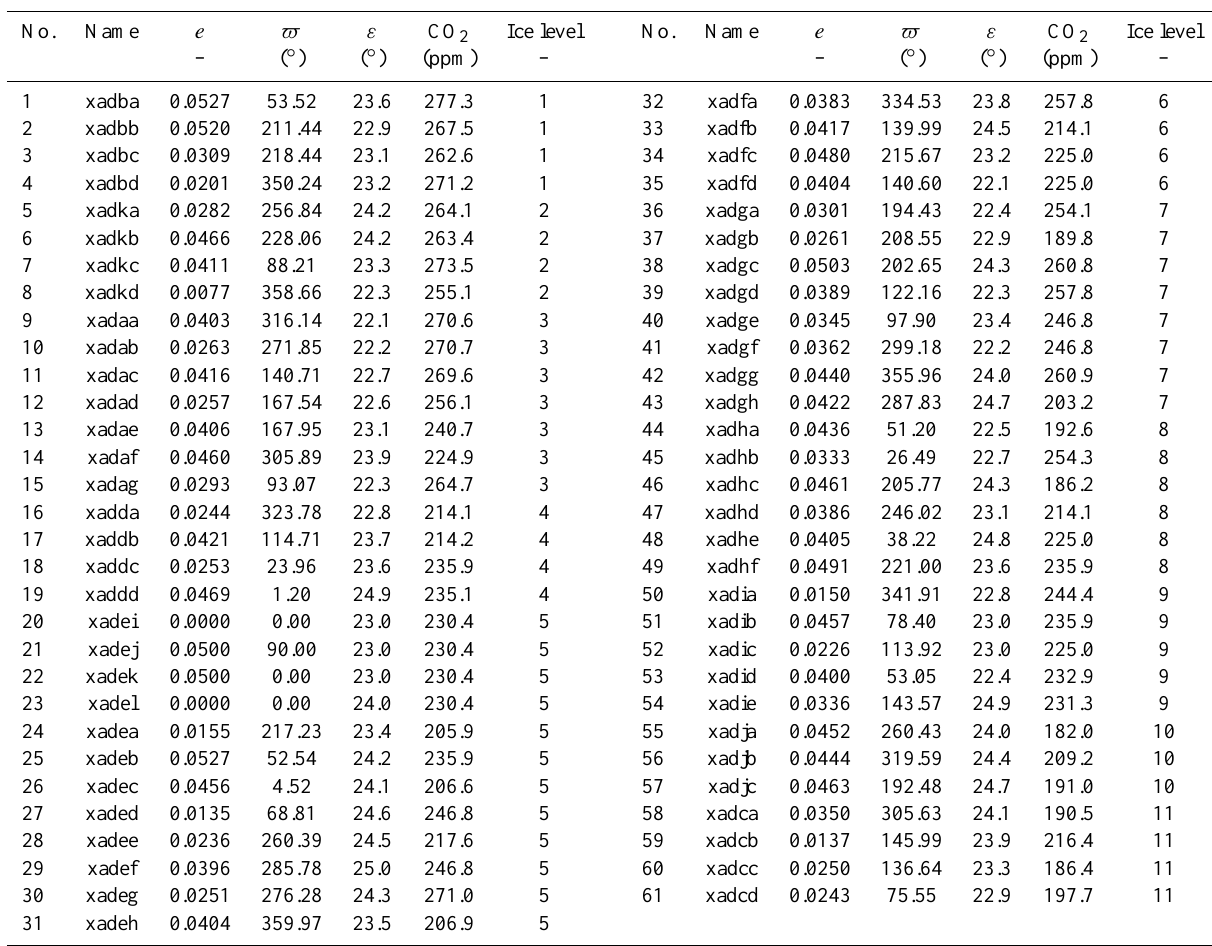
Table 1. Experiment setup: simulation name and number, astronomical parameters (eccentricity, longitude of the perigee and obliquity), CO 2 concentration and glaciation